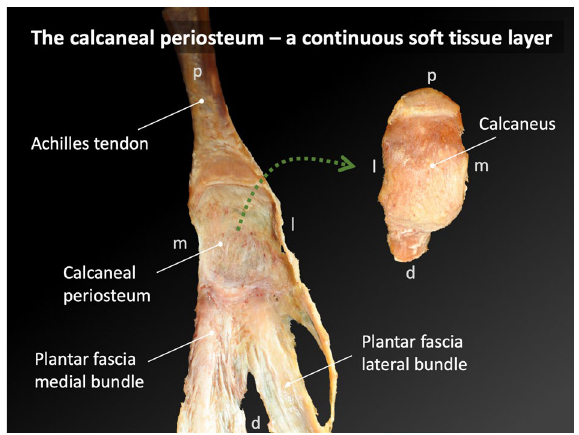
Figure 6. The soft tissue connection between the Achilles tendon (AT) and the plantar fascia (PF) is shown after the calcaneus was removed. The macroscopically most superficial layer of the AT (paratenon of the AT) continues as the calcaneal periosteum to merge with the PF, thereby forming a soft tissue connection between the two. d distal; l lateral; m medial; p